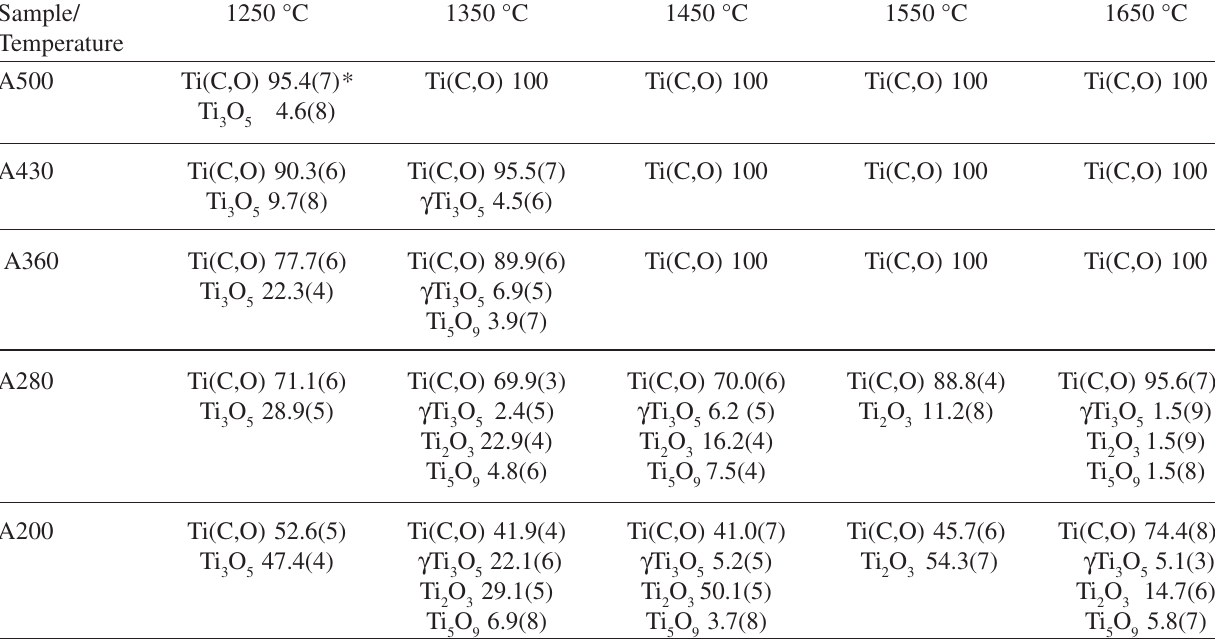
Table 1. Phases content (wt.%) of TiO